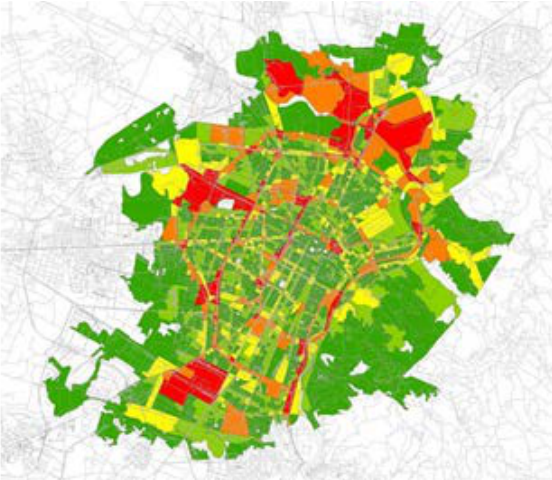
Figure 2. Census areas symbolized by total length of travel path crossing them. Legend: green color = lower values, red color = higher values (Turin)